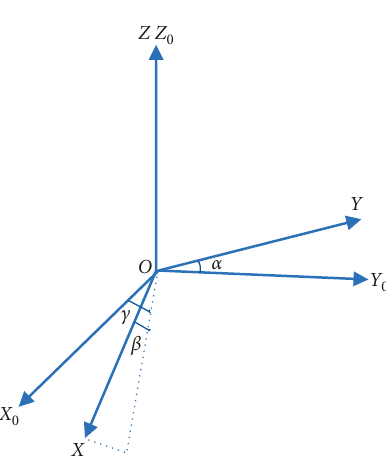
Figure 2: Schematic diagram of nonorthogonal triaxial.